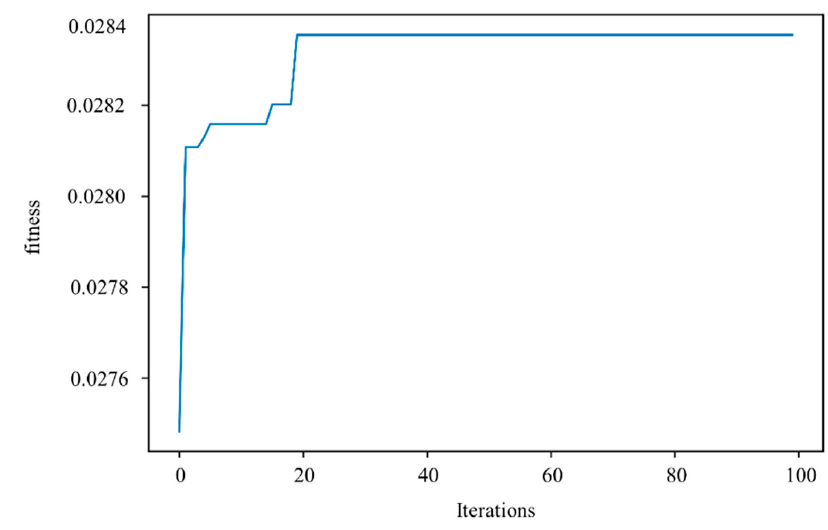
Figure 10. The trend of model fitness in iterations.